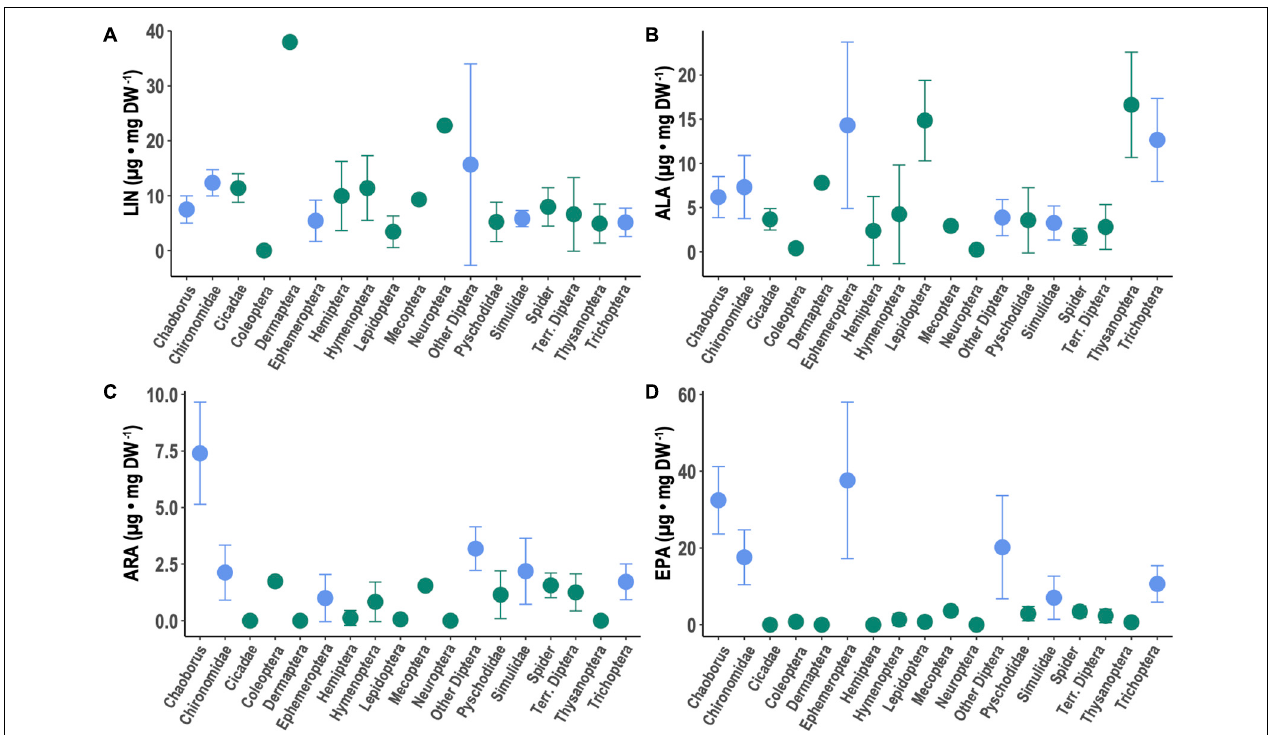
FIGURE 3 | Content of selected PUFA in aquatic (blue) and terrestrial (green) insect taxa as well as spiders: (A) linoleic acid (LIN; 18:2n-6), (B) α -linolenic acid (ALA; 18:3n-3), (C) arachidonic acid (ARA; 20:4n-6), and (D) eicosapentaenoic acid (EPA; 20:5n-3). Data represent composite means ( ± 1 SD). Data on aquatic insects are from Martin-Creuzburg et al. (2017). Lepidoptera here are larval Lepidoptera (i.e., caterpillars).